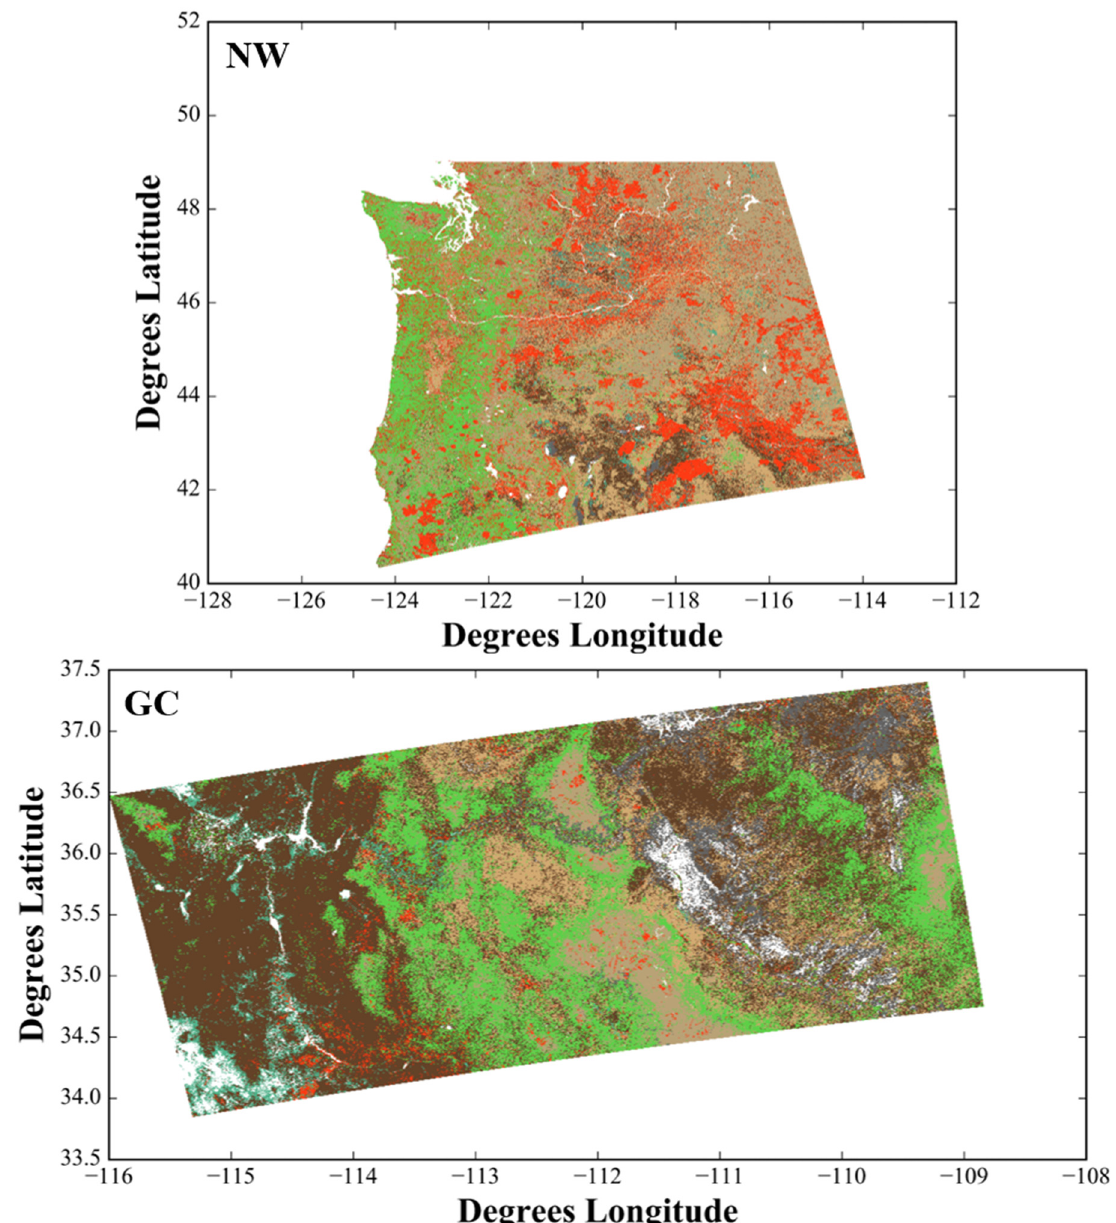
Figure 10. Existing Vegetation Type (EVT) classifications within the Pacific Northwest (NW) and Grand Canyon (GC) prototype areas. A total of 150 vegetation types in the NW and 55 in the GC are represented in these images. Note that coloration has been simplified and uses LANDFIRE color classes (https://landfire.gov/CSV/LF140/LF_140EVT_09152016.csv, accessed 11 June 2019).